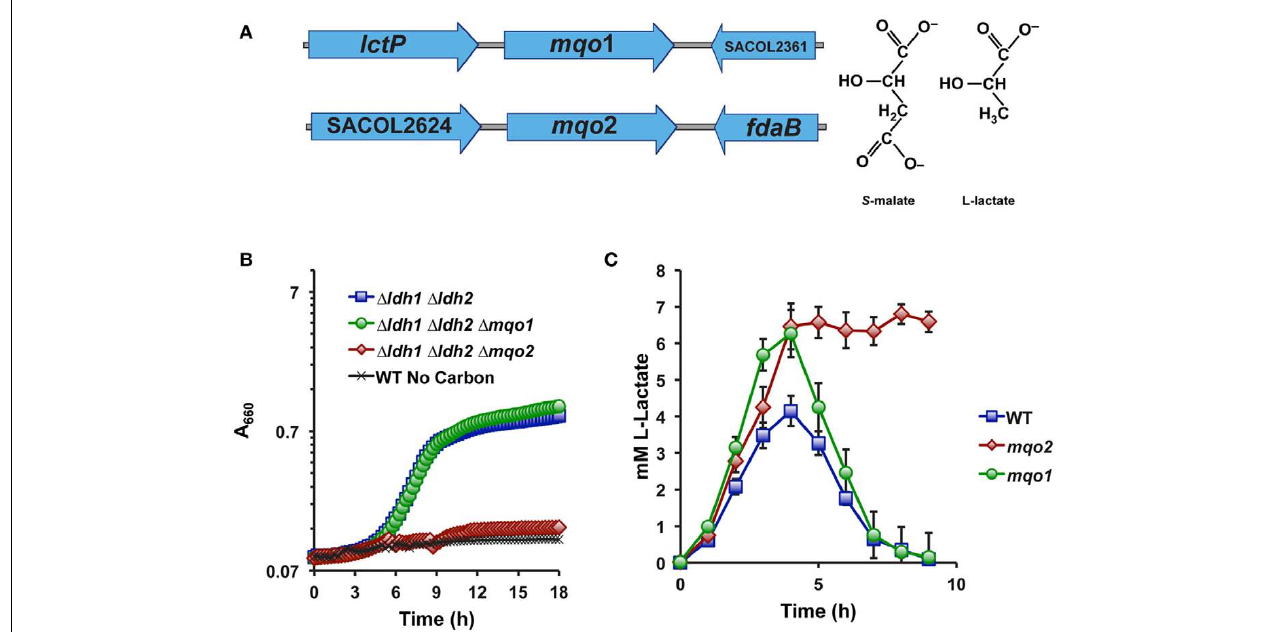
abolishes the ability to utilize L-lactate. Cells were grown aerobically in chemically defined medium with 0.2% L-lactate as the primary carbon source. Residual growth on medium components was subtracted out of depicted curves (see Materials and Methods). (C) The L-lactate excreted following NO · -exposure cannot be reassimilated in a Δ mqo 2 mutant. Cells were grown in chemically defined medium as described in Figure 1B .